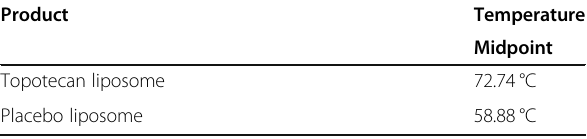
Table 10 Glass transition temperature In DSC for topotecan liposome and placebo